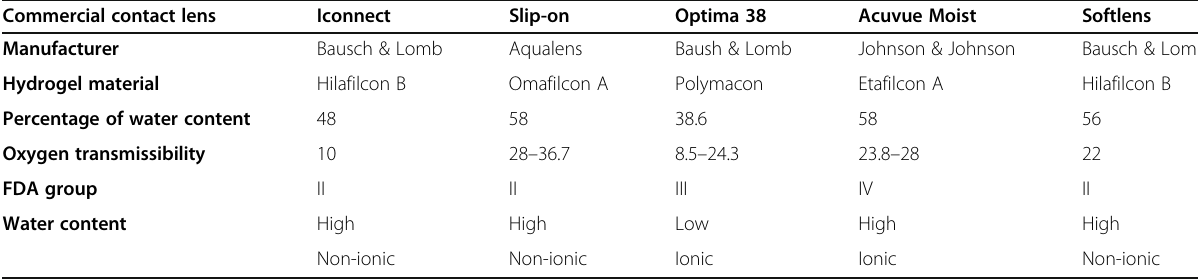
Table 3 FDA-approved silicon contact lenses and their